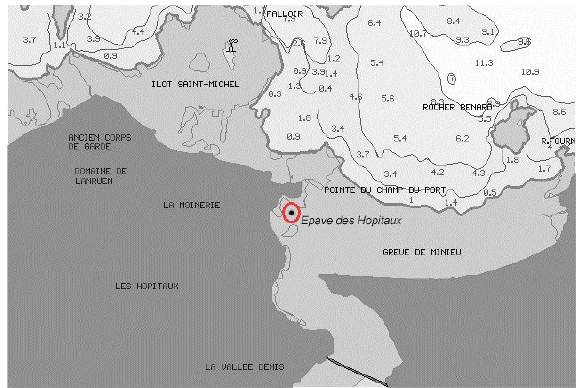
Figure 2. Site map with wreck position